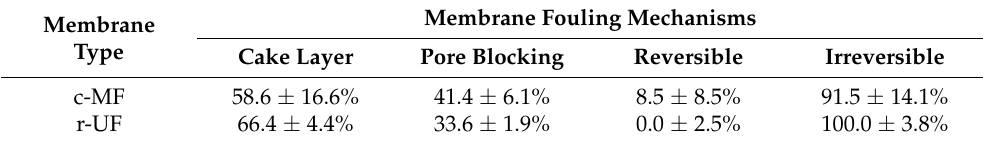
Table 4. Relative contribution (%) of different membrane fouling mechanisms for the c-MF and r-UF membranes after stages Ib and